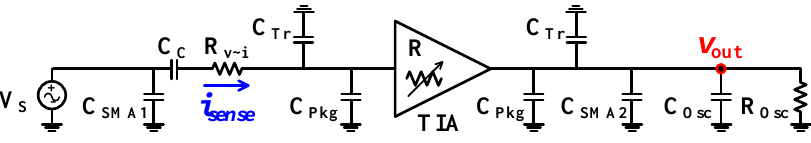
Figure 10. TIA open-loop test method, showing one-half of the differential signal path for simplicity.